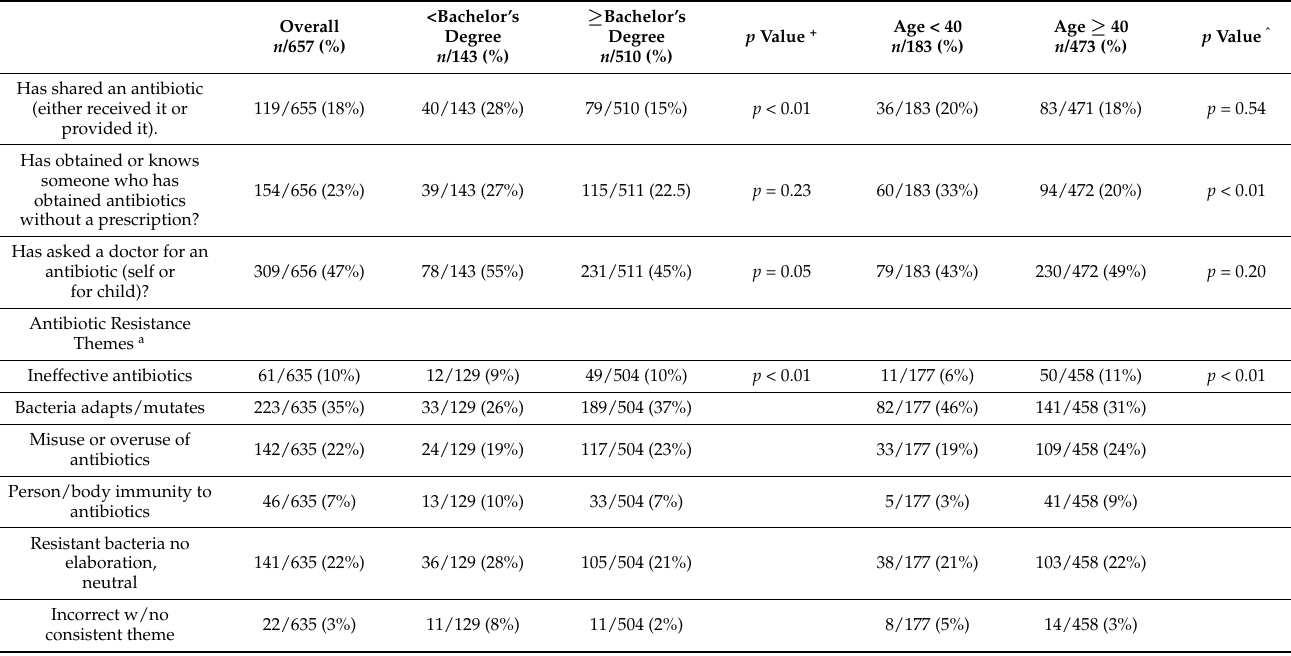
Table 2. Respondent characteristics and antibiotic use